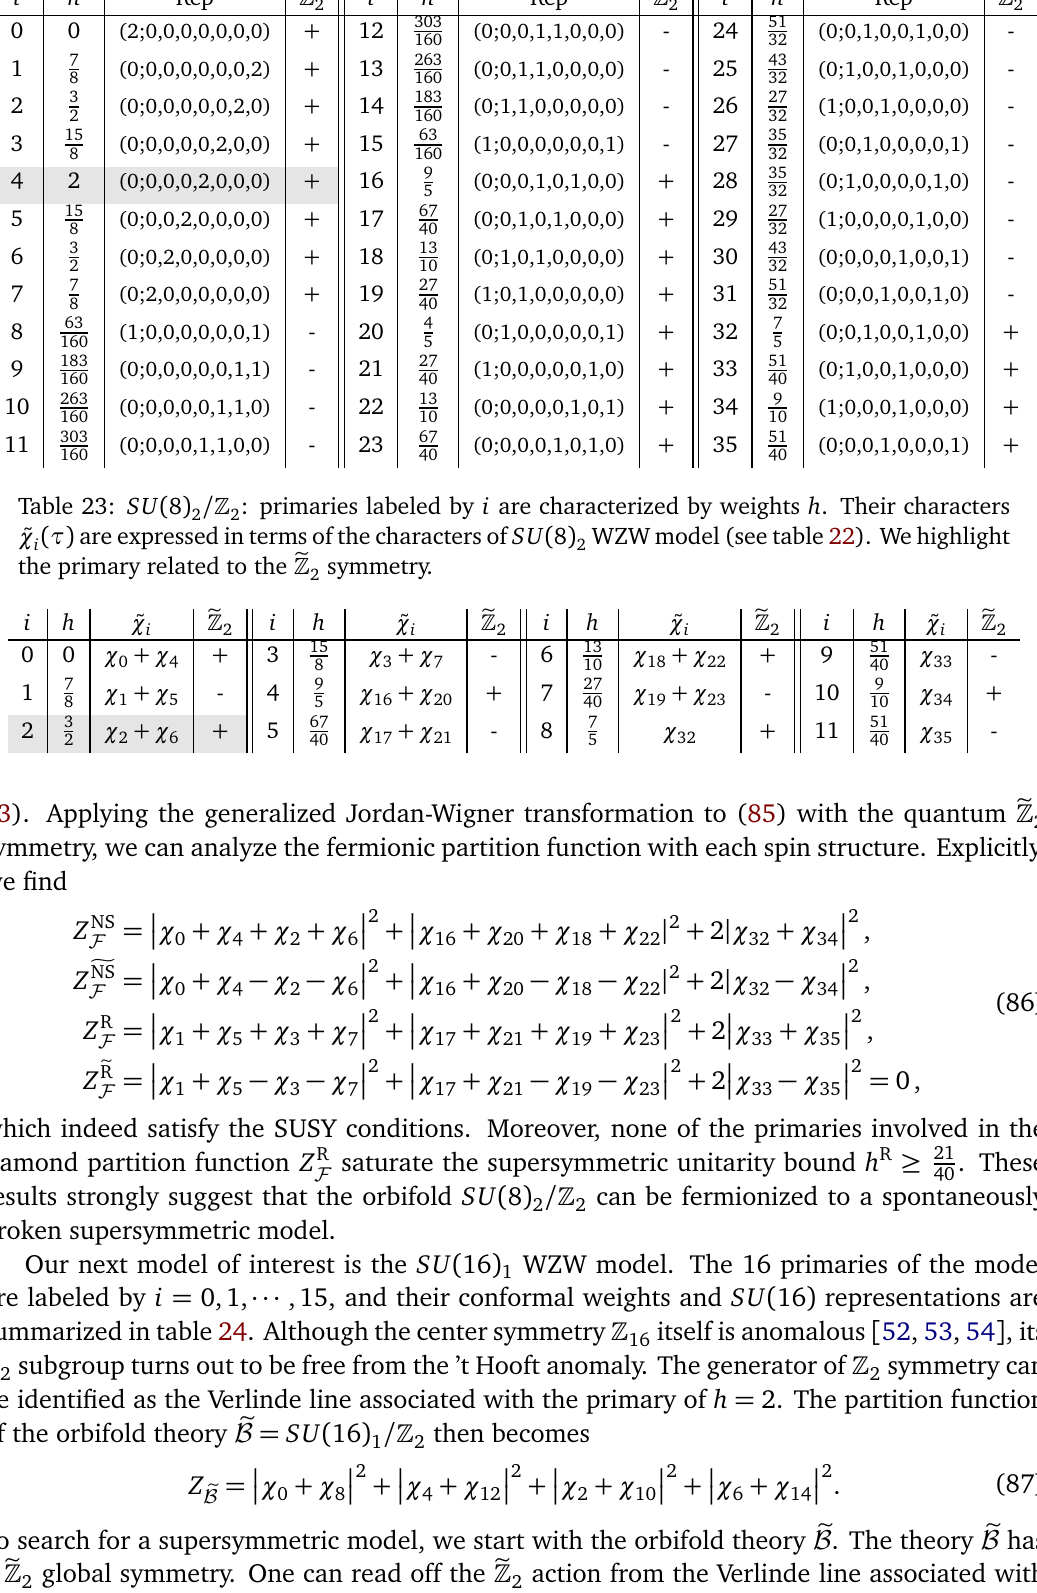
( τ ) . We highlight the primary related to the center i